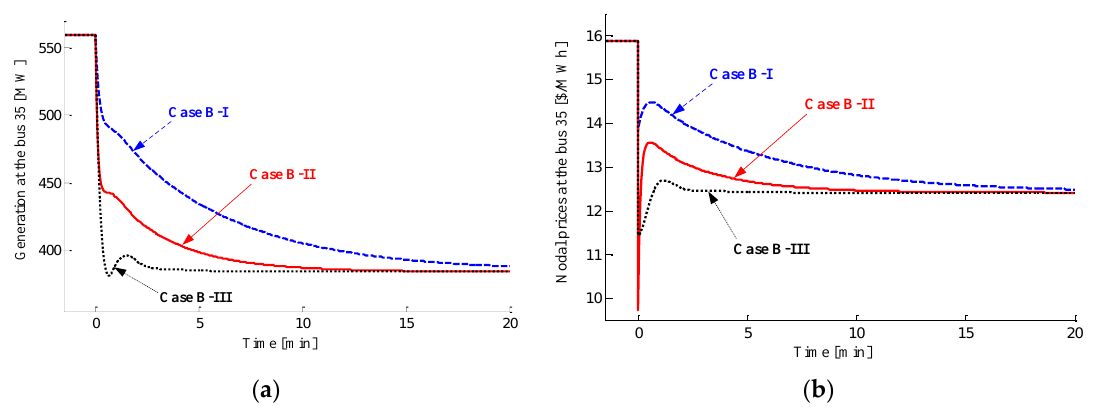
Figure 8. Simulation results for selected bus 35 in the line trip scenario using the framework: ( a ) amount of generation; and ( b ) nodal prices.